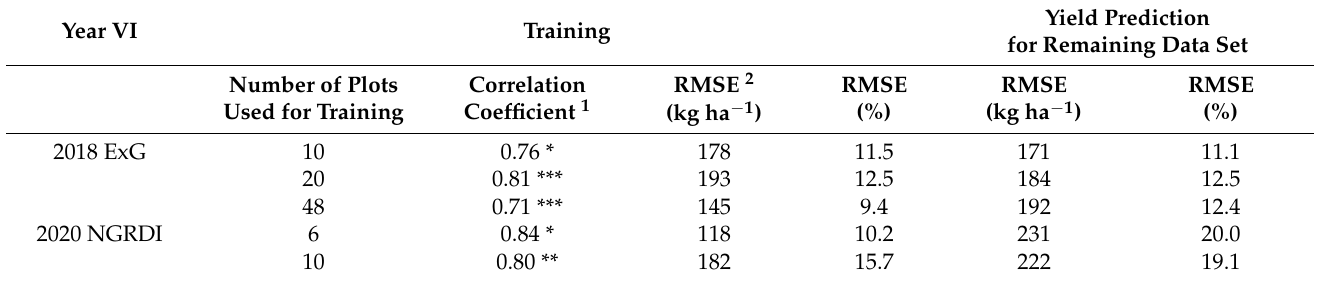
Table 1. Correlation between vegetation indices (VI) and yield in training data sets and yield predictions for the remaining part of data sets. Selection of data from